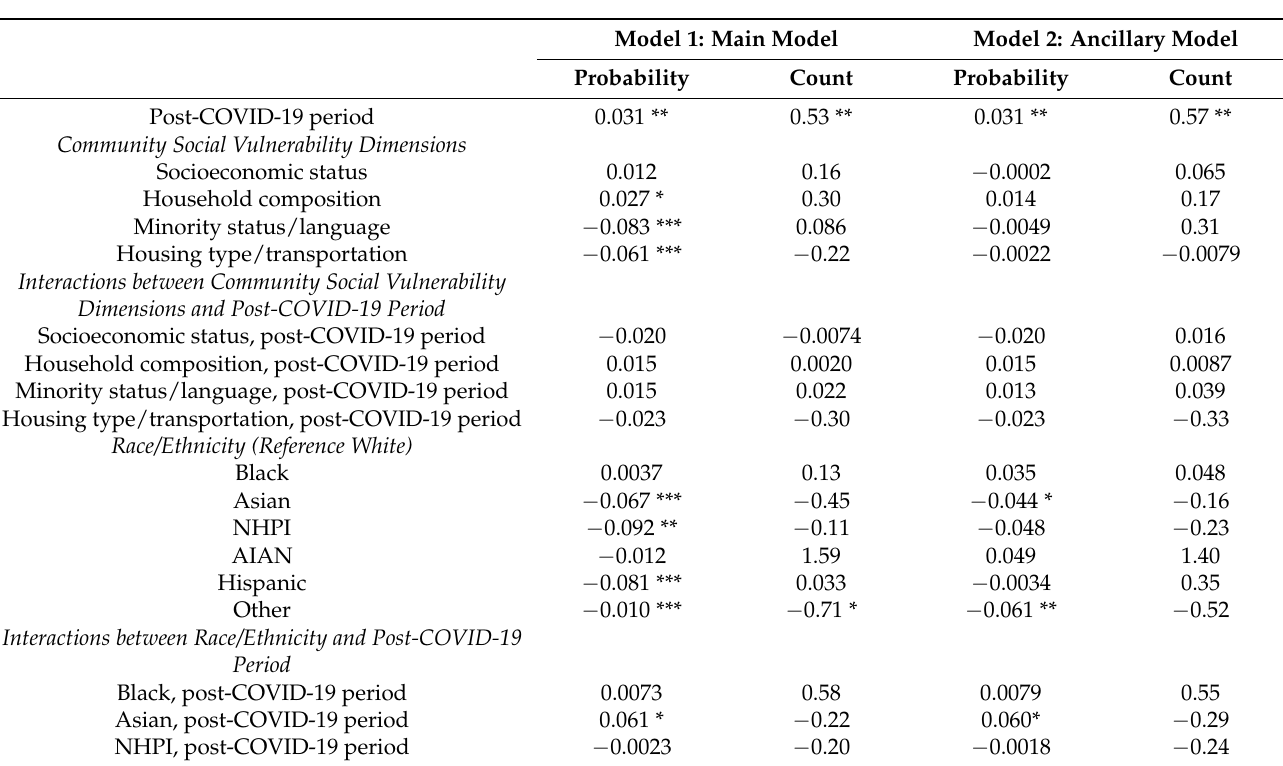
Table 4. Probability and count of specialty visit utilization among individuals diagnosed with COVID-19. Model 1: Main Model Model 2: Ancillary